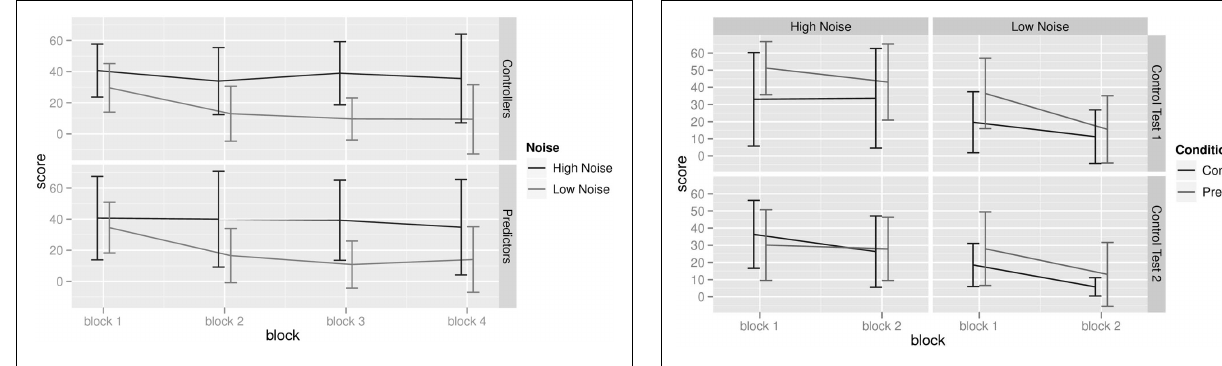
F (1,56) = 6.38, p = 0.014, partial η 2 = 0.102. Follow-up t